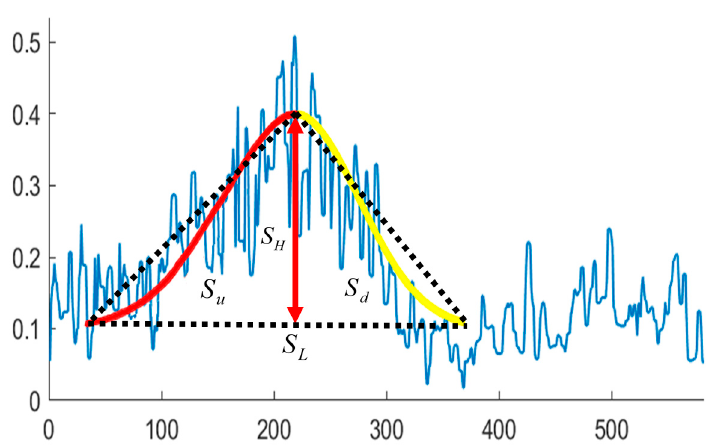
Figure 22. Asymmetric index